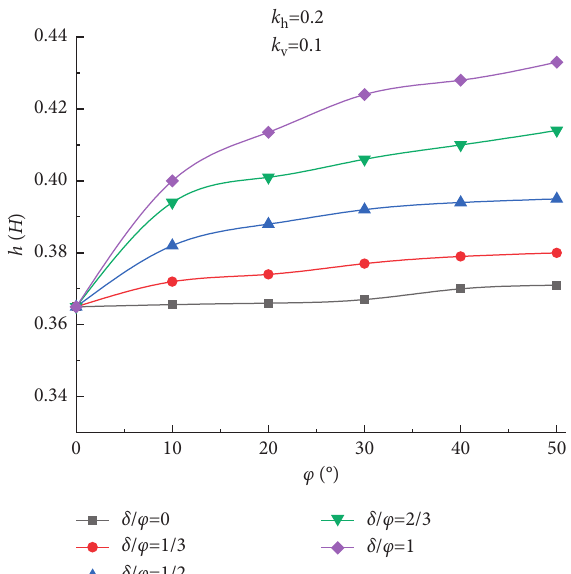
Figure 13: The variation curve of the height of the resultant force acting point with δ and φ